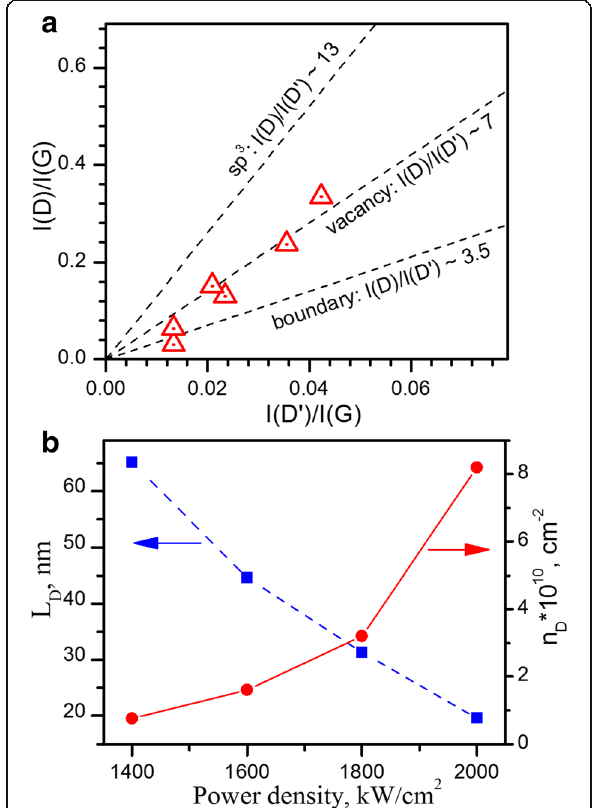
Fig. 4 Defect characterization. a I D / I D ′ ratio for the laser exposed graphene (Fig. 3). Dashed lines show I D / I D ′ dependence for different type of defects [13]. b Estimated distance ( L D ) between the defects and their density ( n D ) on the laser power density at 1-h